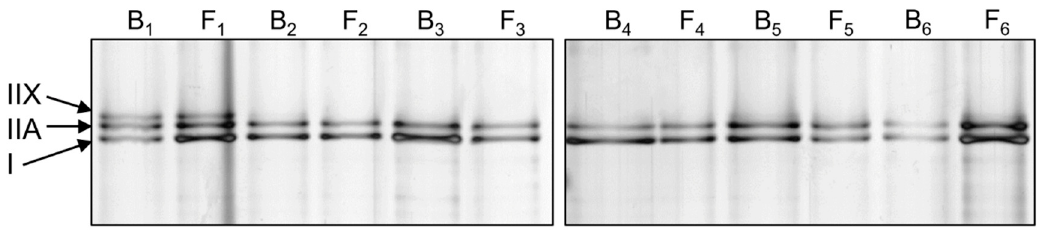
Figure 3. Representative silver-stained myosin heavy chain (MHC) SDS-PAGE results from six participants (1–6, B, baseline; F, final follow-up). Table 5. Relative proportions of di ff erent myosin isoforms in SDS-PAGE at perimenopause and early postmenopause. Baseline Final Follow-Up Myosin Isoform n = 25 n = 25 Type I (%)